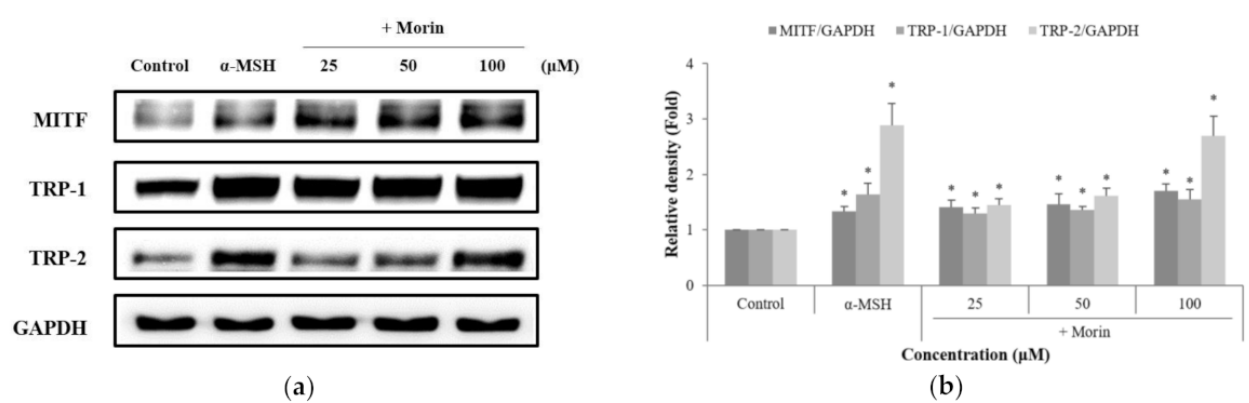
Figure 4. Effects of morin on the protein levels of melanogenic enzymes (TRP-1, TRP-2) and MITF. B16F10 mouse melanoma cells were treated with morin or α -MSH at the indicated concentration for 24 h. ( a ) MITF, TRP-1, and TRP-2 protein expressions were detected by western blotting. ( b ) Results were normalized against GAPDH expression. The data are presented as the mean ± SD of at least three independent experiments; * p < 0.05 compared with the